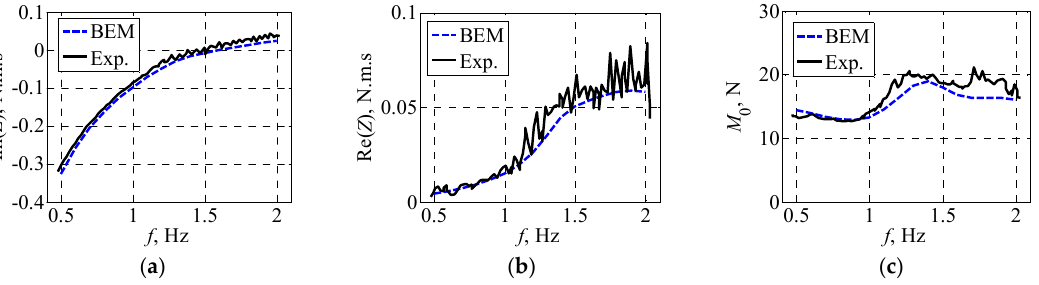
Figure 3. Comparison of hydrodynamic coefficients between the BEM and experimental results for 1:100 scaled Duck at floating state No. 8: ( a ) added inertia; ( b ) radiation damping coefficient; and ( c ) excitation moment coefficient.